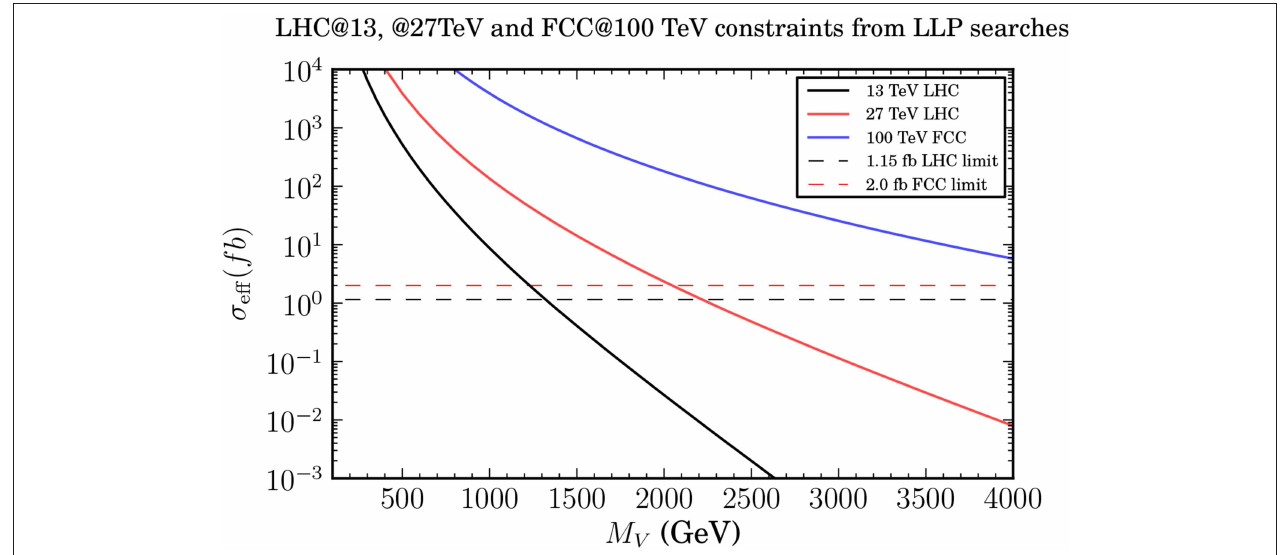
V ± V 0 ) V + V − ) at leading order for the vector isotriplet model for 13 and 27 TeV LHC energies σ ( pp 2 σ ( pp = → + →